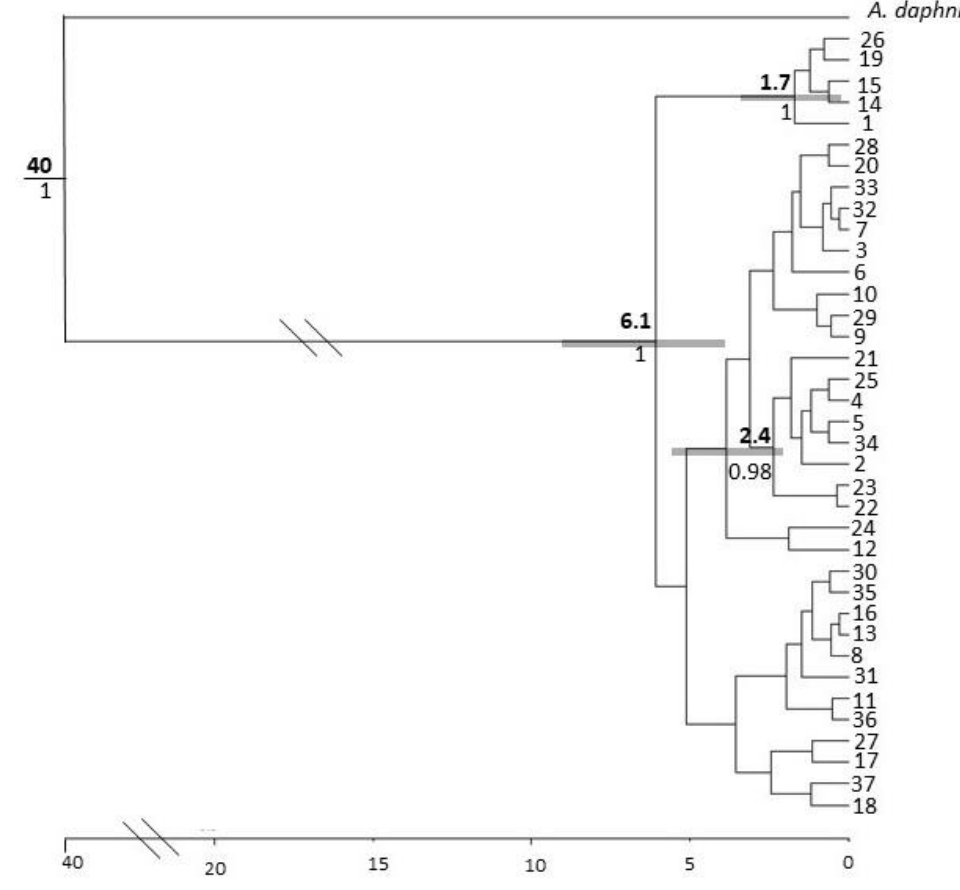
Figure 6. Phylogenetic tree of A. pruinocarpa constructed from four cpDNA regions. Numbers above nodes indicate age in millions of years, numbers below lines are posterior probabilities of well supported internal nodes. Double slash lines indicate truncation of branch lengths for ease of visualisation. Note the tree was dated based on the cpDNA substitution rate identified for the Mimosoid clade in [70]. Grey boxes represent 95% confidence intervals (HPD). Scale bar represents time (Ma).